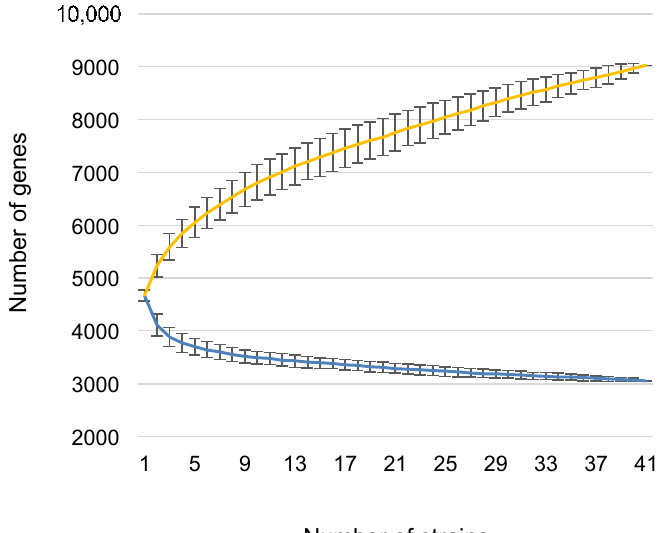
Figure 3. Rarefaction and accumulation curve estimates of Dickeya dianthicola core and pan-genomes. The number of shared genes (blue line) and the total number of genes (yellow line) were determined as genome sampling increased. Comparisons were made based on matrices of gene presence/absence. Randomised genome sampling was carried out 100 times to obtain the average number of genes for each sample comparison number and standard deviations.